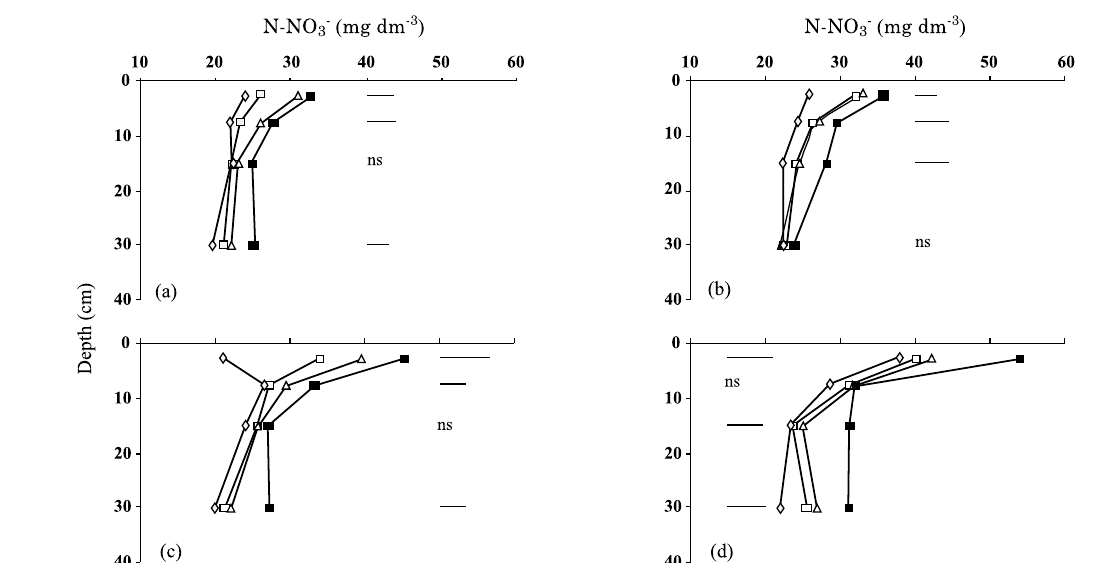
Figure 2. pH in the soil profile as affected by lime